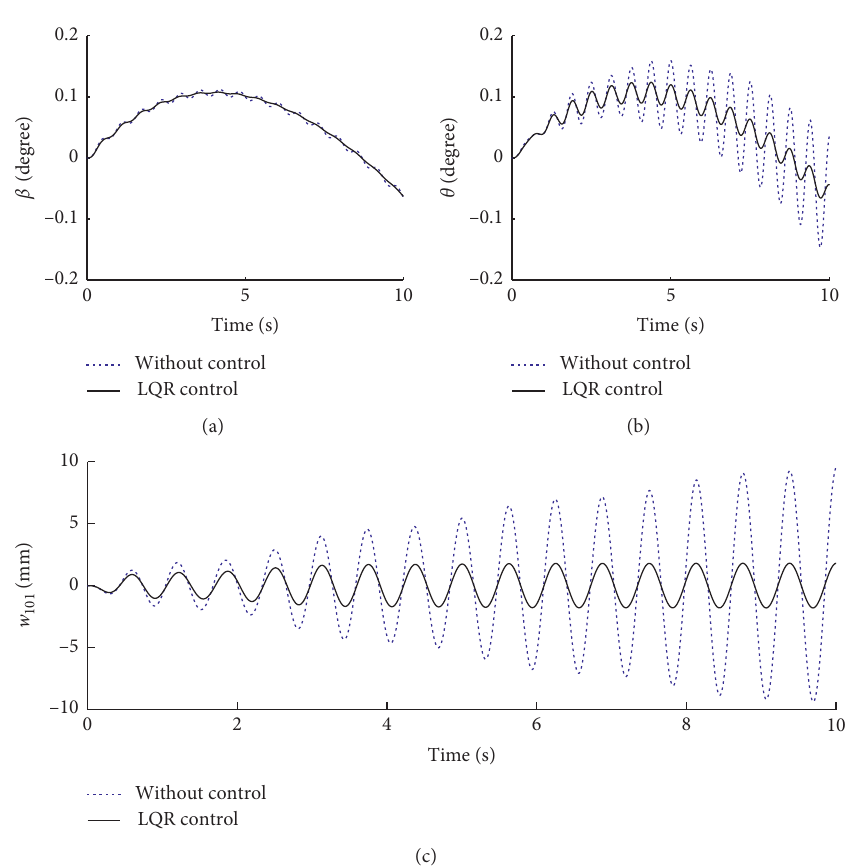
Figure 10: Response of the controlled system with harmonic